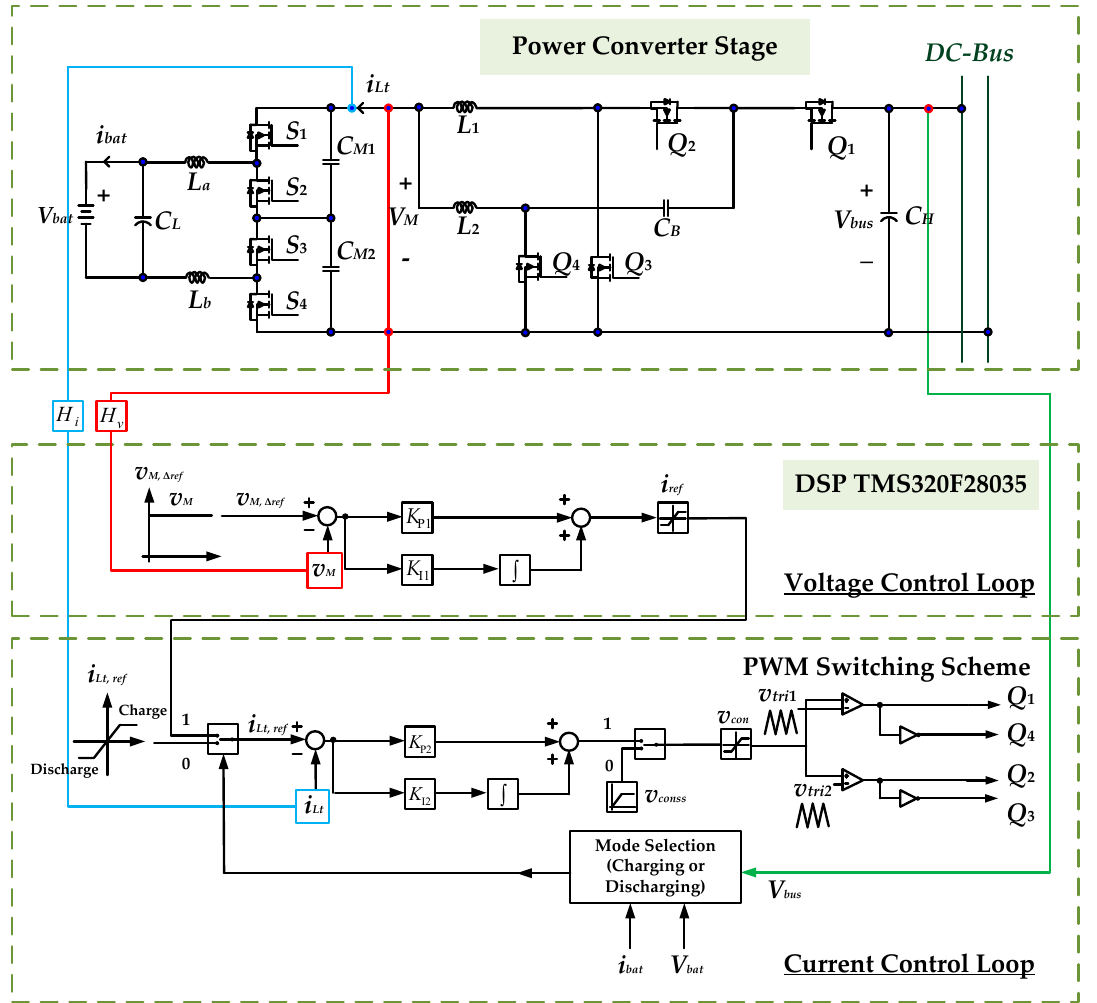
Figure 3. The developed control system for the high-gain RC-BDC.